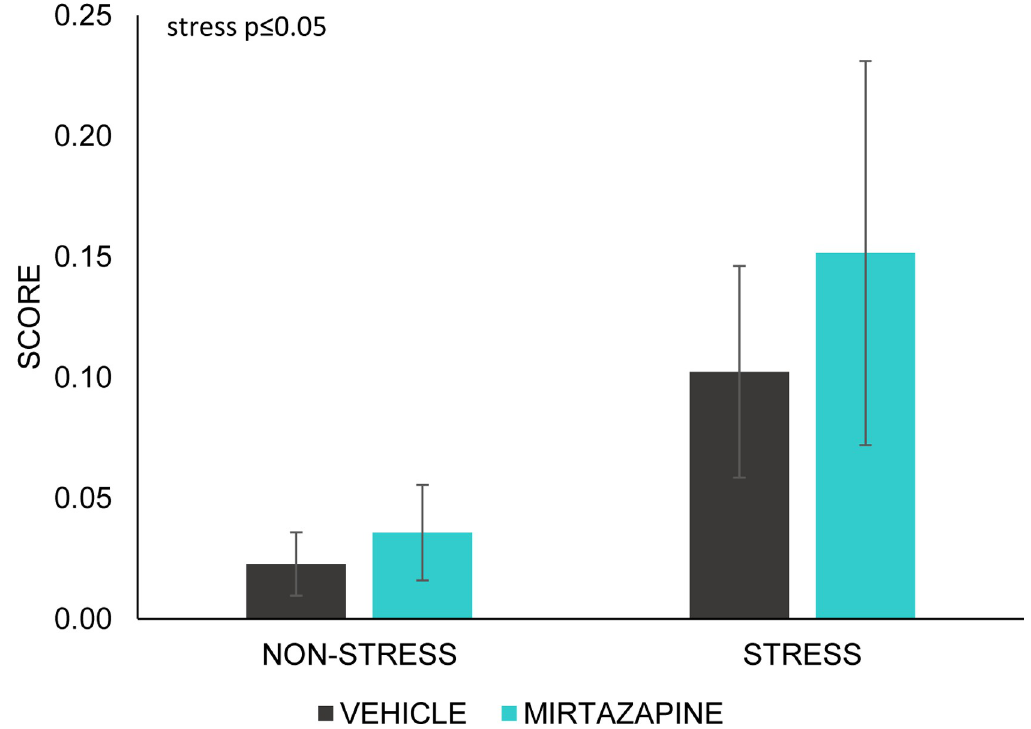
Fig 4. Grimace scale test. Data represent mean ± SEM. n = 6–7 animals/group.